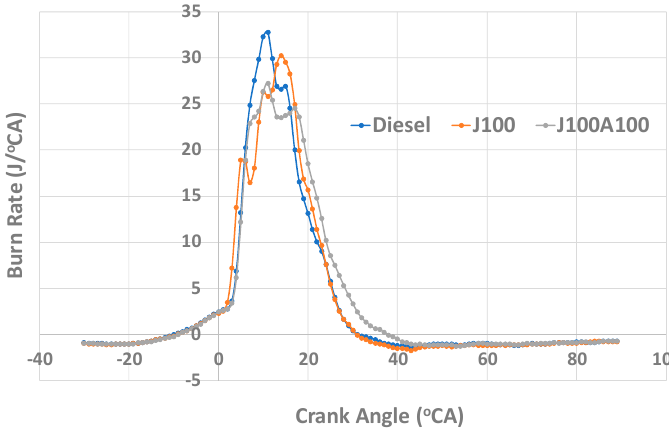
Figure 13. Heat release rate at 60% load.